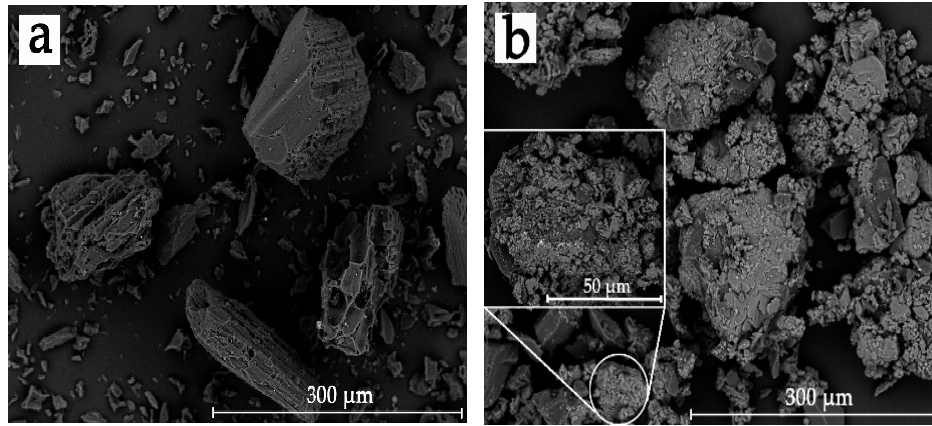
Figure 2. SEM images of surface morphology: ( a ) BC and ( b ) BC-m.